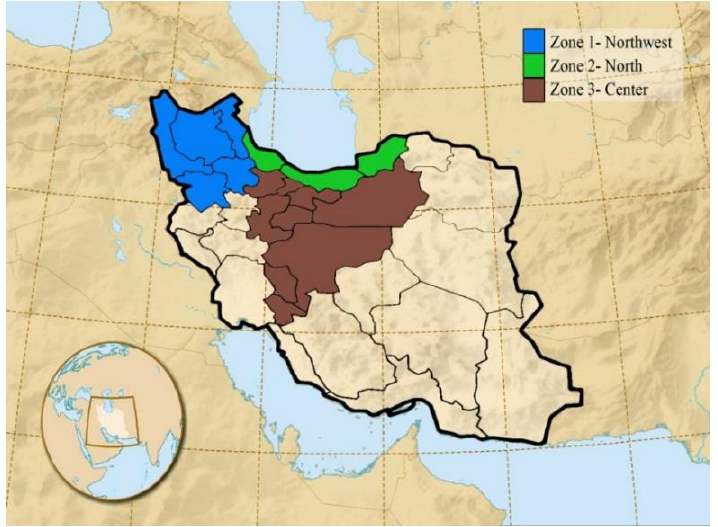
Figure 1. Classification of the considered study zones according to various climate conditions in Iran